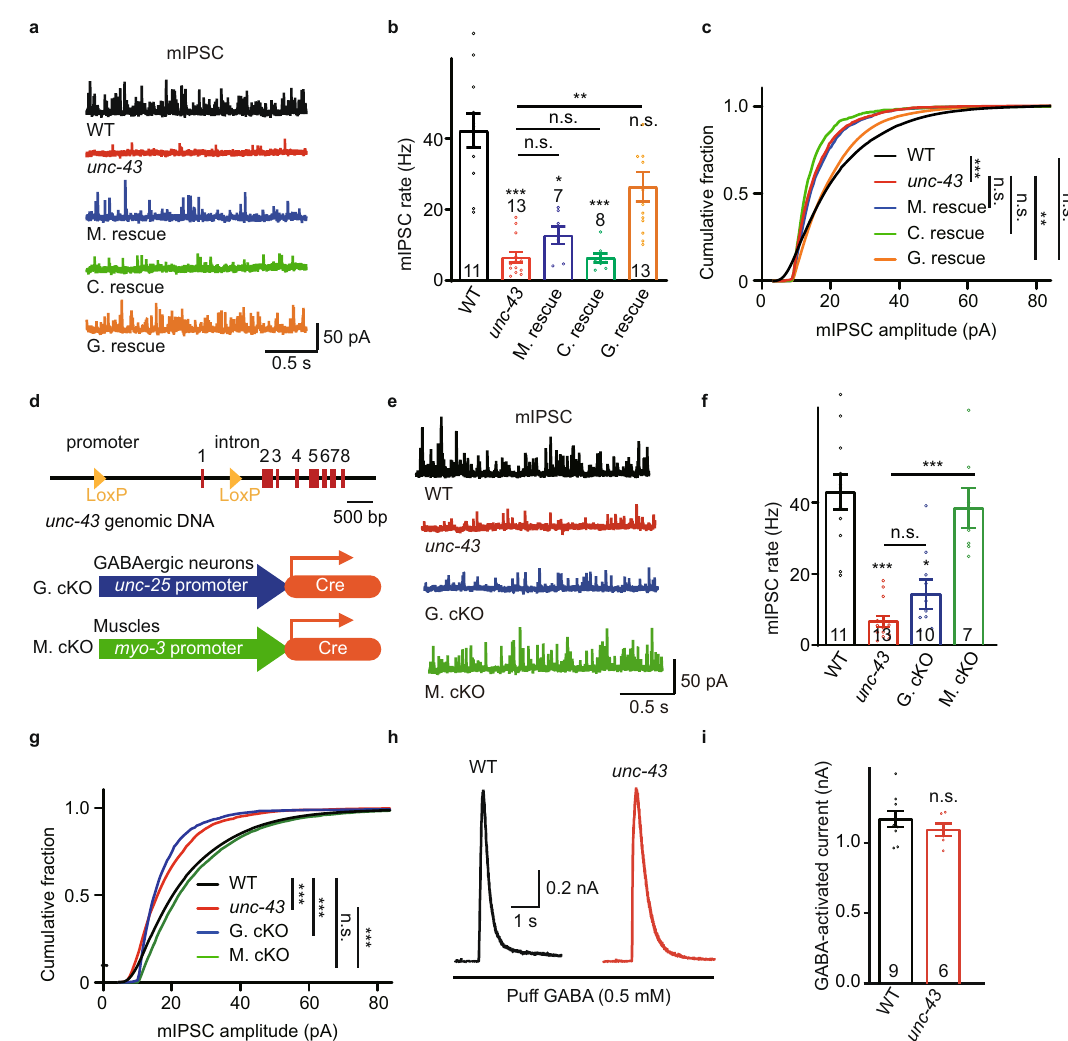
Fig. 3 | Presynaptic UNC-43/CaMKII modulates inhibitory synaptic transmis- sion. a – c Endogenous inhibitory synaptic transmission was assessed by recording mIPSCs from body-wall muscles. The defects of mIPSC in the unc-43 mutants were rescued by transgenic expression of UNC-43 in GABAergic motor neurons (G. rescue), but not by UNC-43 expression in cholinergic neurons (C. rescue) or in body-wall muscles (M. rescue). Representative mIPSC traces ( a ), mIPSC rates ( b ,Dataarepresentedasmeanvalues+/ − SEM,Nsrepresentthenumberofanimals tested.), and the cumulative fraction of mIPSC amplitude ( c ) are shown. Kruskal – Wallis test with post-hoc Dunn ’ s multiple comparisons. * p <0.05, ** p <0.01,*** p <0.001,n.s.notsigni fi cant. d Schematicforconstructionofthe unc- 43 conditionaldeletionlines.TwoLoxPsiteswereinsertedintothegenomicloci(at the promoter and the fi rst intron of UNC-43 K11E8.1a to K11E8.1l) by CRISPR/Cas9, the minigene encoding Cre recombinase under unc-25 and myo-3 promoters were